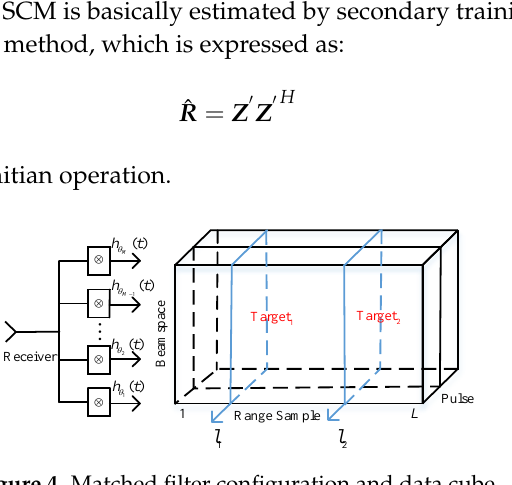
Figure 4. Matched filter configuration and data cube.